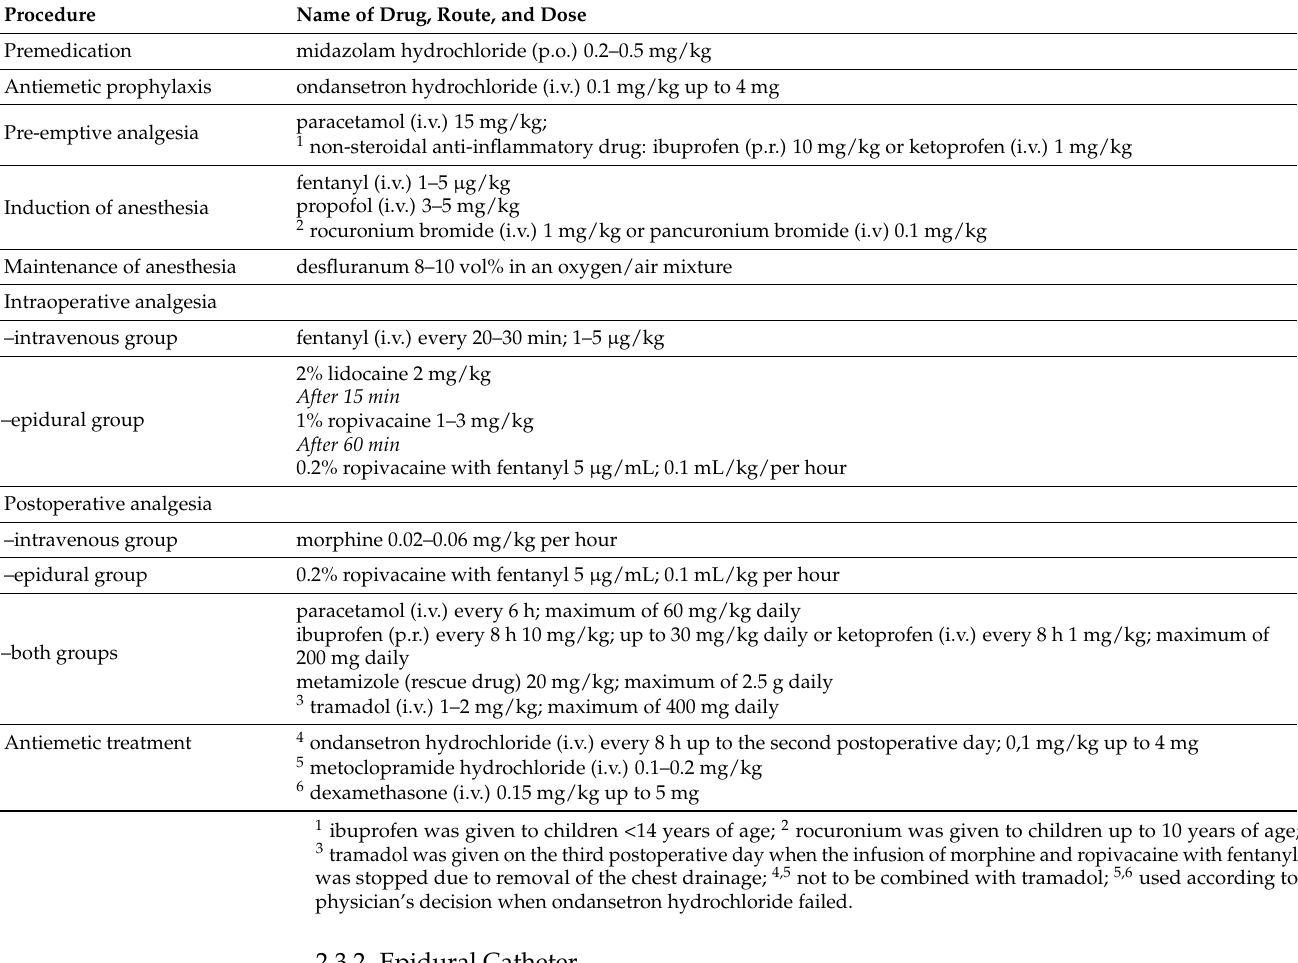
Table 1. Protocol for the perioperative and intraoperative administration of drugs in the intravenous and epidural